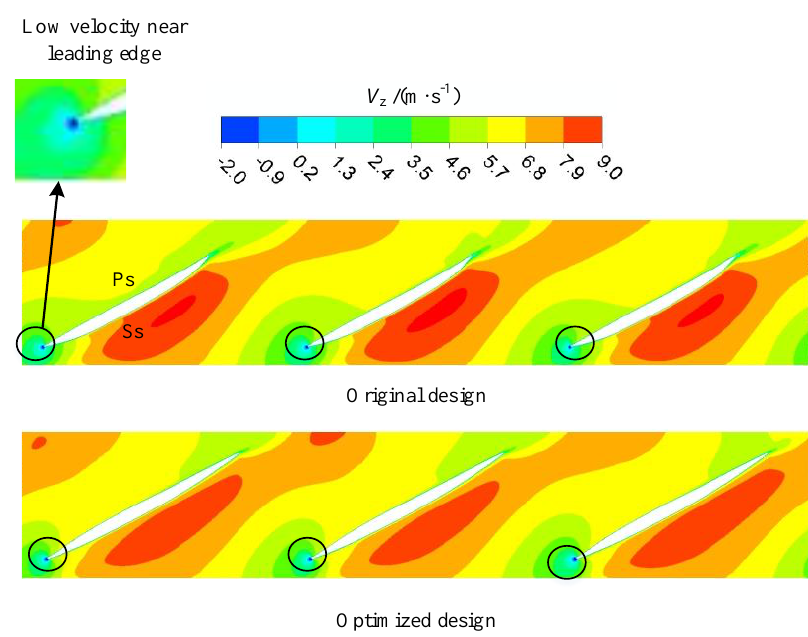
Figure 13. Comparison of the velocity axial distribution in the impeller between the original design and optimized design under the forward design flow rate (span = 0.5).